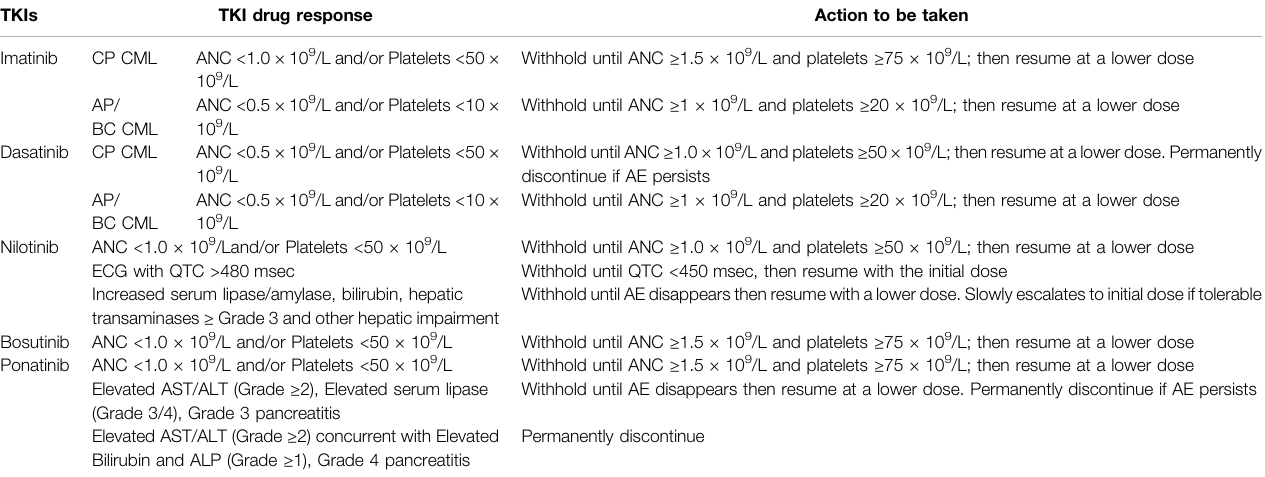
TABLE 2 | The adverse conditions and dose modi fi cations of TKIs during CML treatment. TKIs TKI drug response Action to be